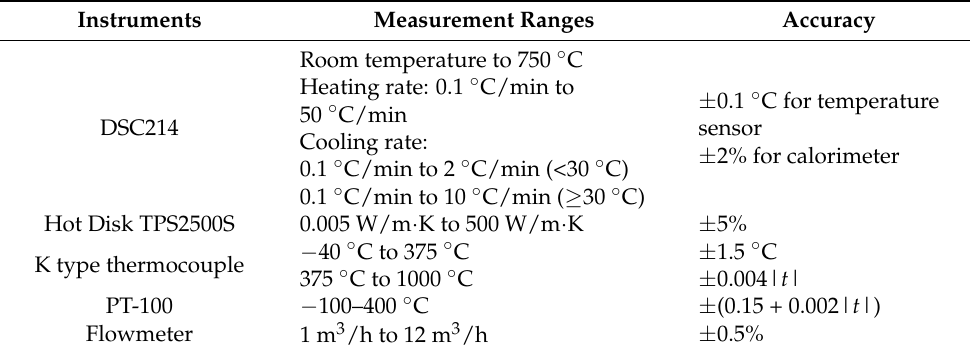
Table 2. Information of the main detectors and